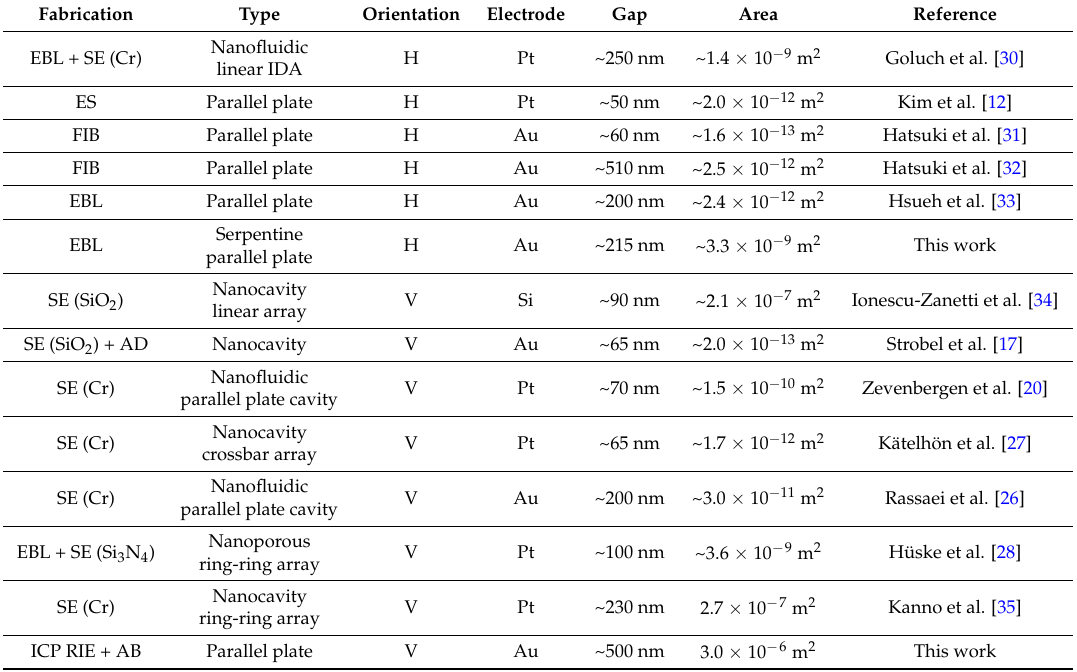
Table 1. Variety of fabricated nanogaps suited towards electrochemical sensing